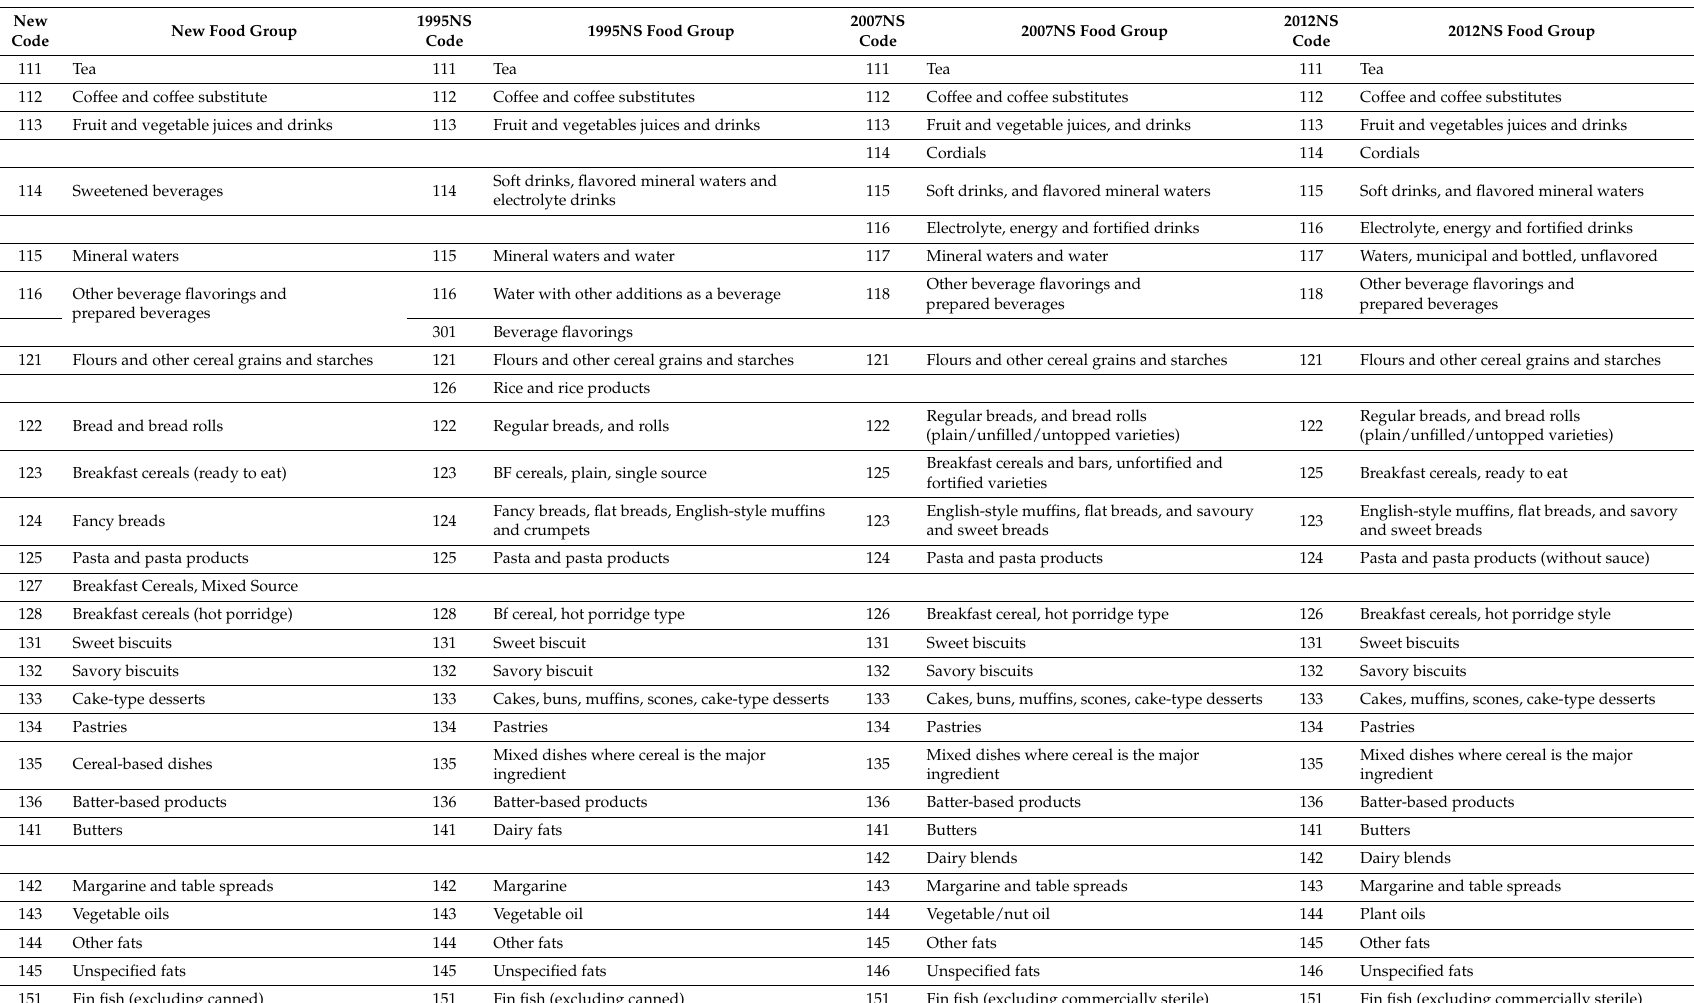
Table A1. Re-coding of food groups in the AUSNUT